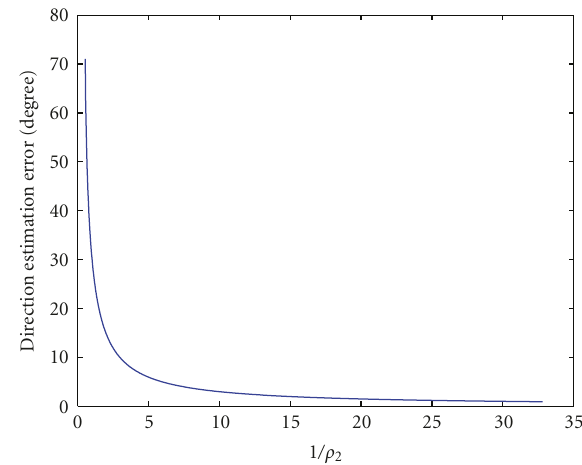
Figure 2: Direction estimation error versus 1 /ρ 2 .